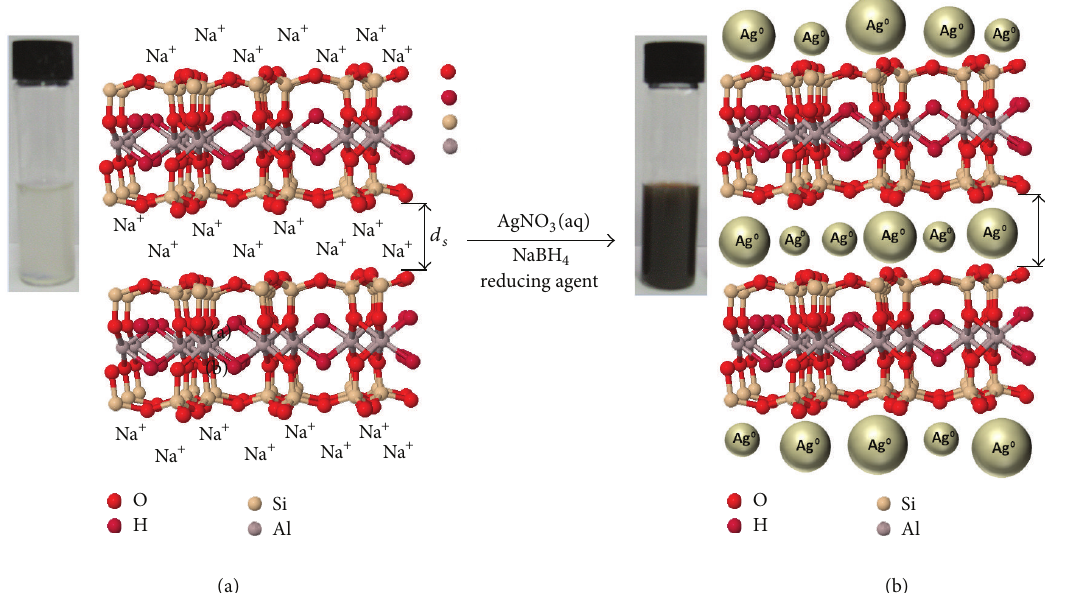
Figure 1: Schematic illustration of the synthesized Ag-NPs in the interlayer space of MMT suspension by chemical reduction